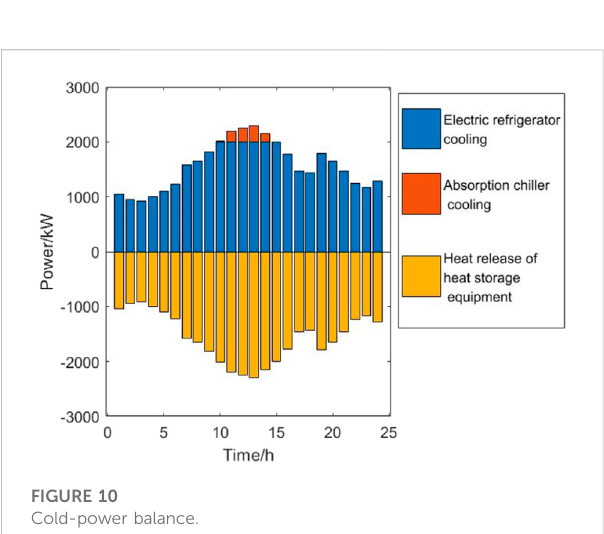
FIGURE 9 Heat-power balance.